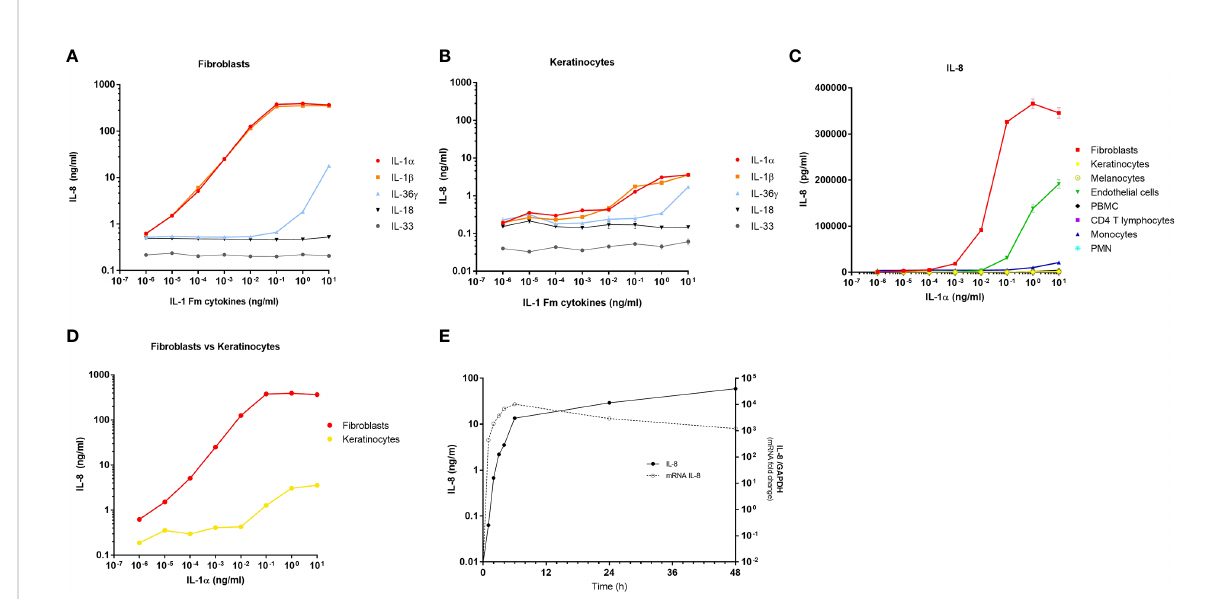
FIGURE 3 Dermal fi broblasts are the best responder skin cells to IL-1 a / b . Dermal fi broblasts (A) and epidermal keratinocytes (B) were stimulated for 24 h with increasing concentrations of IL-1 family members including, IL-1 a , IL-1 b , IL-36 g , IL-18 and IL-33. The fi broblast response to cytokines was evaluated by measuring IL-8 concentrations in culture medium by ELISA. Several cell types including fi broblasts, keratinocytes, melanocytes, endothelial cells, PBMC, CD4 T cells, monocytes and PMN were stimulated for 24 h with increasing concentrations of IL-1 a before measuring IL-8 concentrations in culture medium by ELISA (C) . Comparison between fi broblast and keratinocyte responses to increasing concentrations of IL-1 a by IL-8 measurements in culture medium after 24 h of stimulation (D) . Kinetics of IL-8 mRNA expression and IL-8 protein release by fi broblasts stimulated with 100 pg/ml of IL-1 a (E) . IL-8 mRNA expression was determined by RT-qPCR and data were presented as relative expression to the housekeeping gene GAPDH. IL-8 dosages in culture medium were performed by